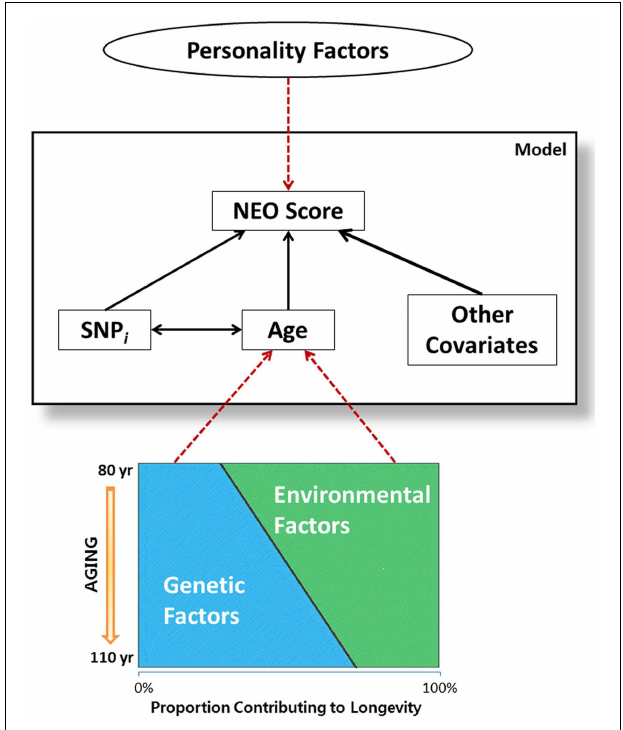
FIGURE 2 | Graphical representation of hypothesis on gene-gene interactions . Attributes inside the large rectangular box are the variables included in the statistical model. Age, which is associated with NEO scores, is reflective of both genetic and environmental factors associated with aging. As genetics factors outweigh the environmental factors in individuals enriched for longevity, SNP-by-age interaction term in the model may imply gene-gene interaction which plays important roles in personality traits, as related to